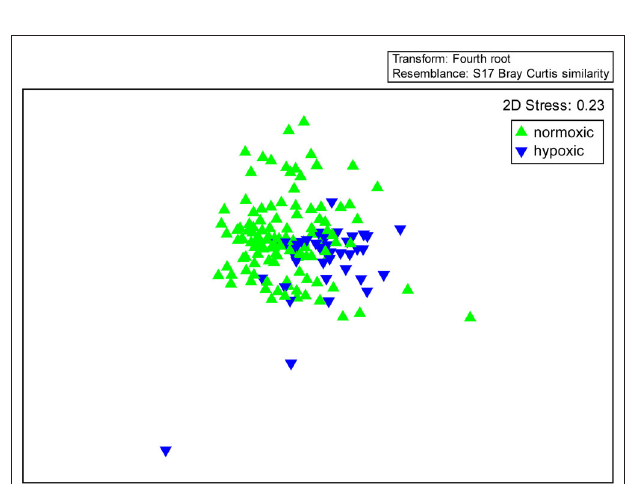
FIGURE 3 | Ordination (non-metric multidimensional scaling) of species abundances in hypoxic and normoxic areas. Another three hypoxic stations were off the scale of this